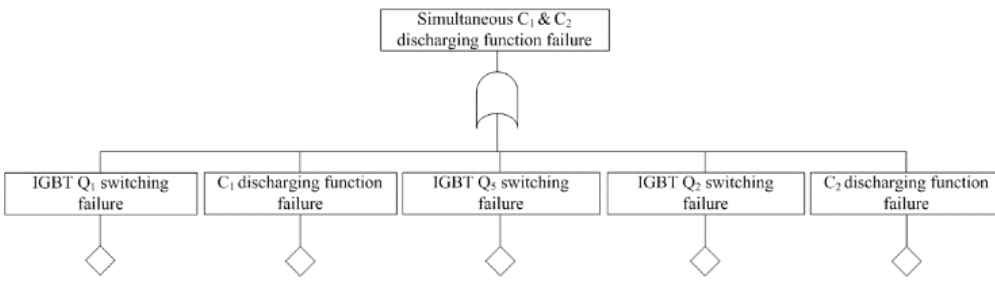
Figure 9. Sub fault tree for Simultaneous C 1 and C 2 discharging function failure.